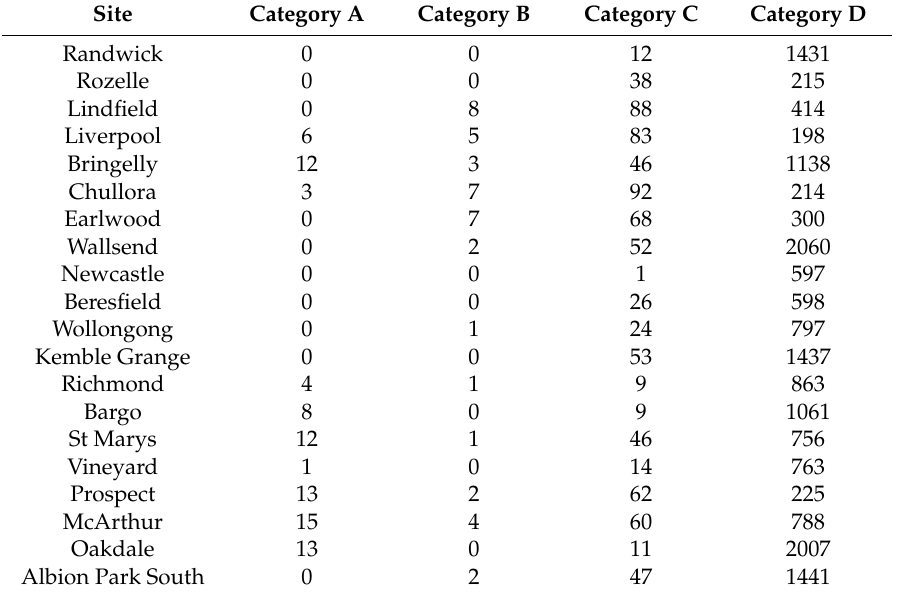
Table 2. Number of observed hourly data that are classified into each smog potential categories at different sites in the GMR for January